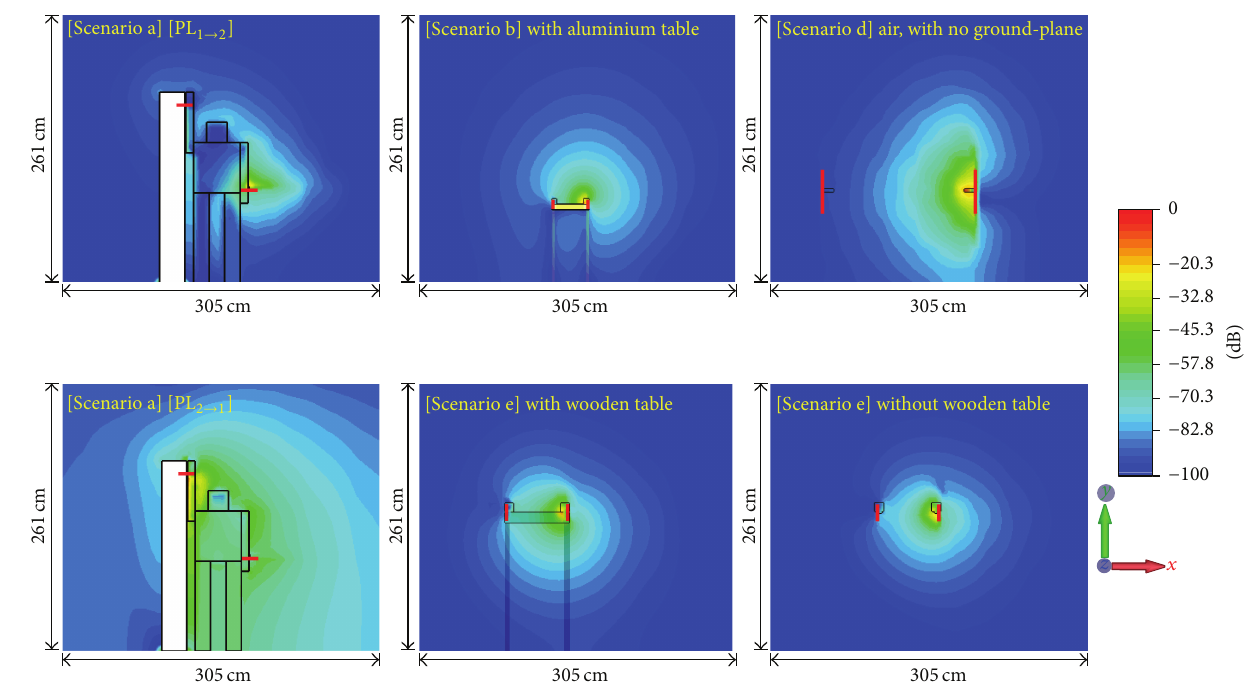
Figure 8: Electric field intensity plots showing distribution in 𝑥𝑦 plane (a single cut along 𝑧 -axis) for selected scenarios in Figure